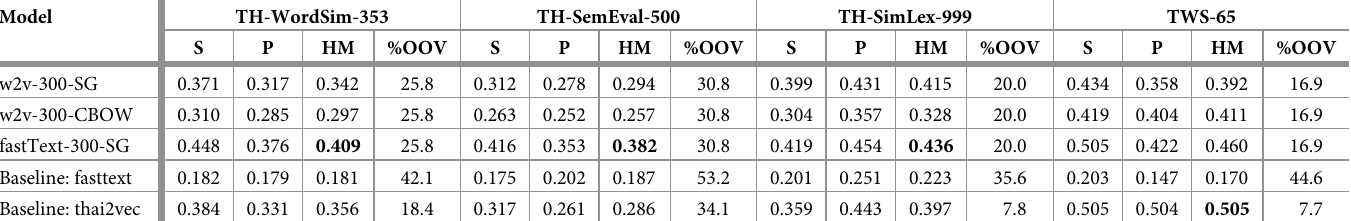
Table 2. Evaluation metrics Spearman ρ (S), Pearson ρ (P) and Harmonic Mean (HM) of the two–for the self-trained models and the pretrained baselines. Further, the ratio of OOV words (%OOV). Model